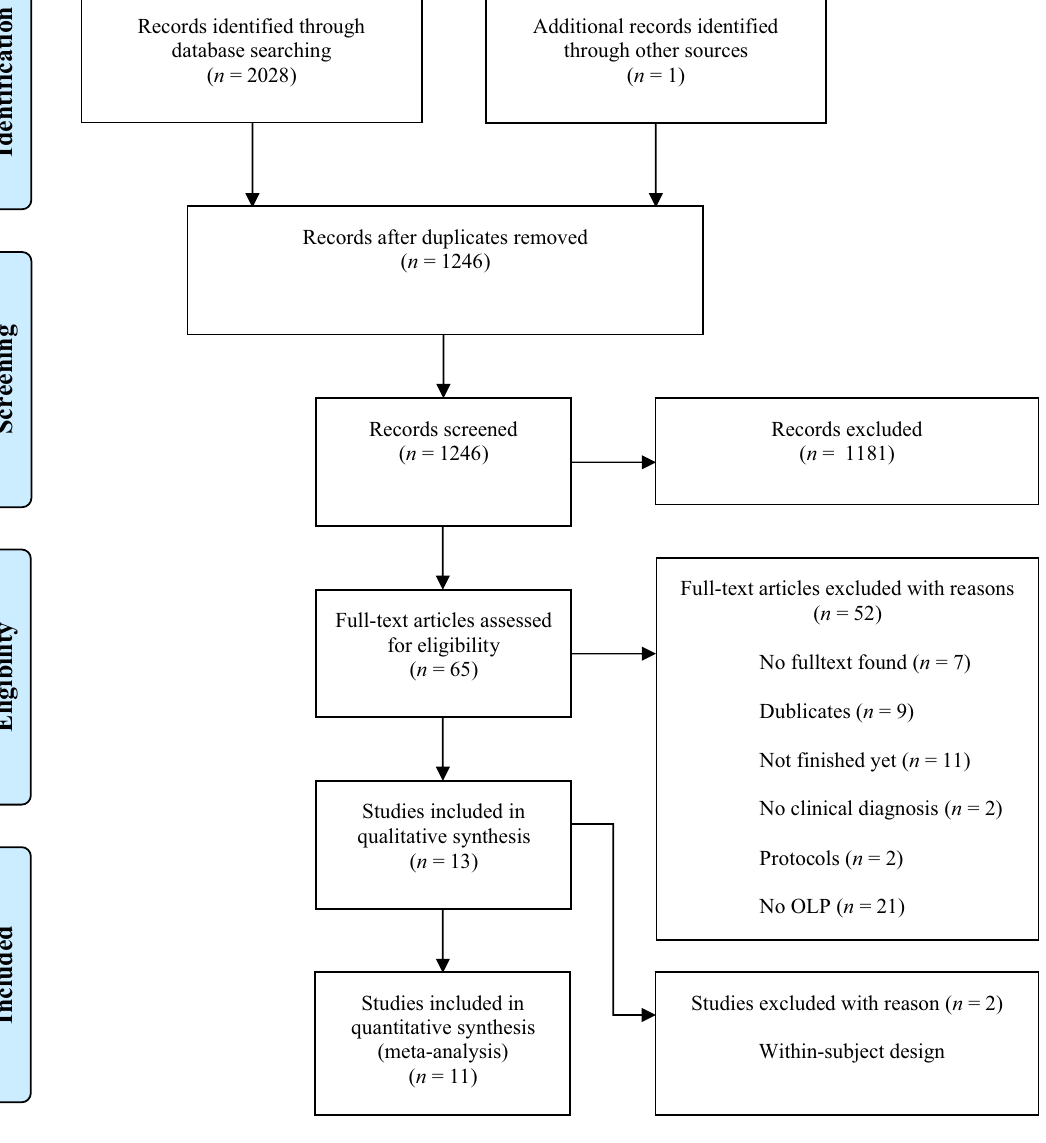
Figure 1. PRISMA flow chart for study